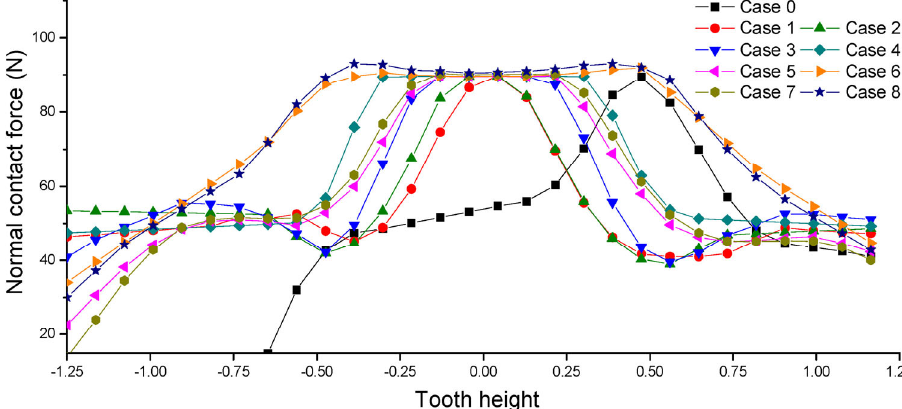
Fig. 7 Normal contact force at different points in the gear.